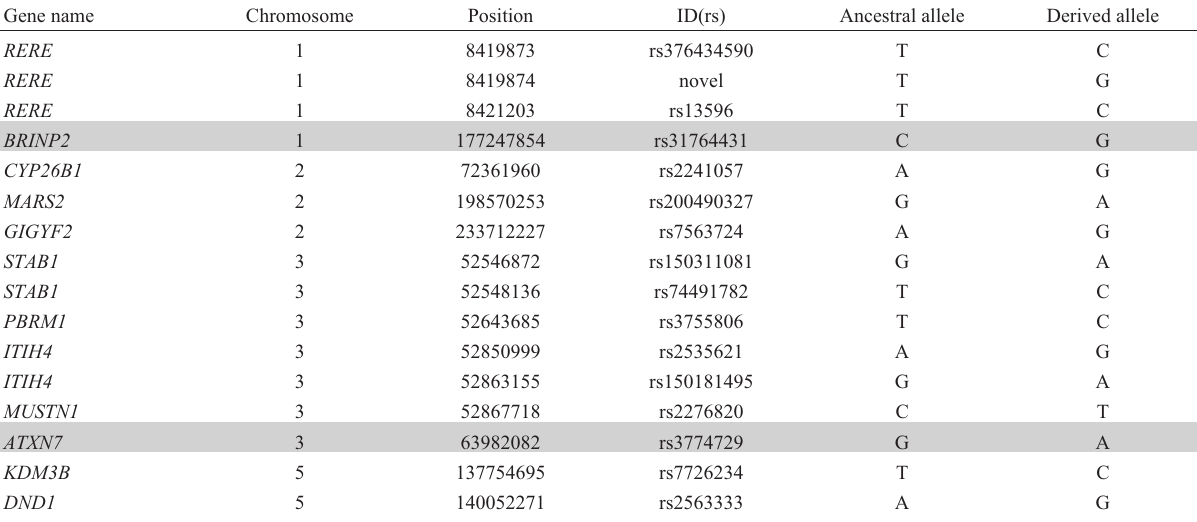
Table 2 - Trans-SNPs within loci associated with schizophrenia according to the Schizophrenia Working Group of the Psychiatric Genomics Consortium